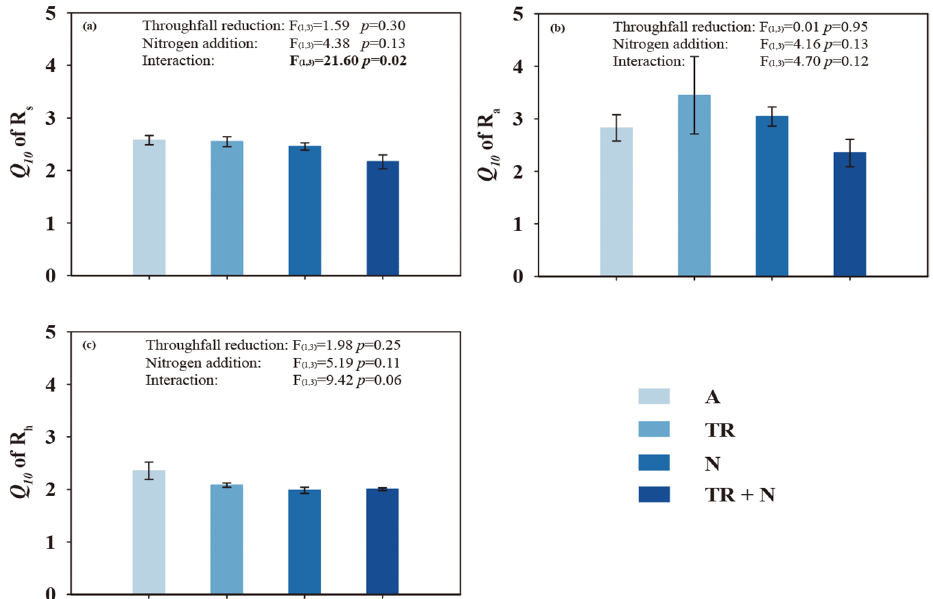
Figure 5. Comparison of temperature sensitivity of soil respiration (R s ) (Graph ( a )), soil autotrophic respiration (R a ) (Graph ( b )) and soil heterotrophic respiration (R h ) (Graph ( c )) under ambient (A), throughfall reduction (TR), N addition (N) and N addition and throughfall reduction (TR + N) treatments. The error bar represented arithmetic means ± stand errors for four replicates.